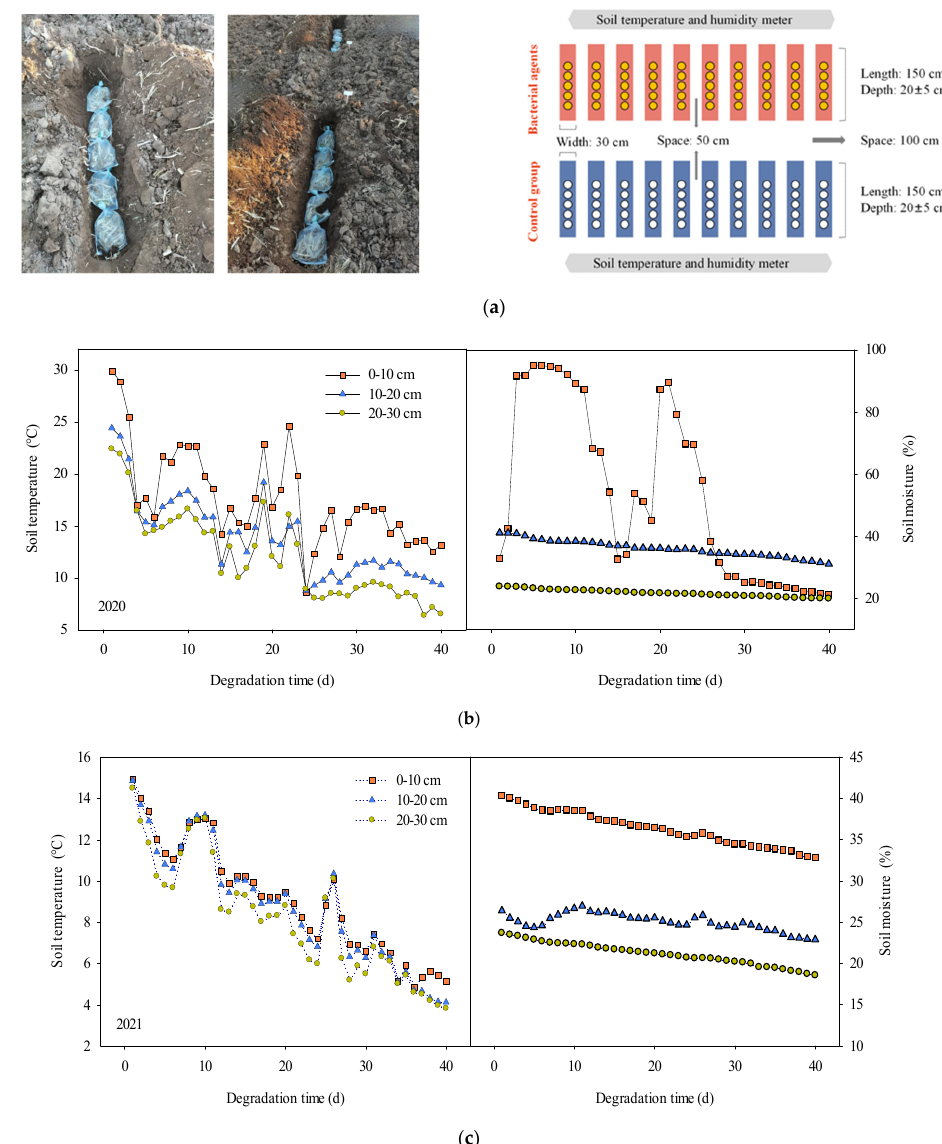
Figure 1. Field test layout and soil environment for bacterial agent assessment. ( a ) Layout of field tests. Temperature and moisture in different soil layers during ( b ) 2020 and ( c ) 2021. Table 1. Soil fertility before sowing.